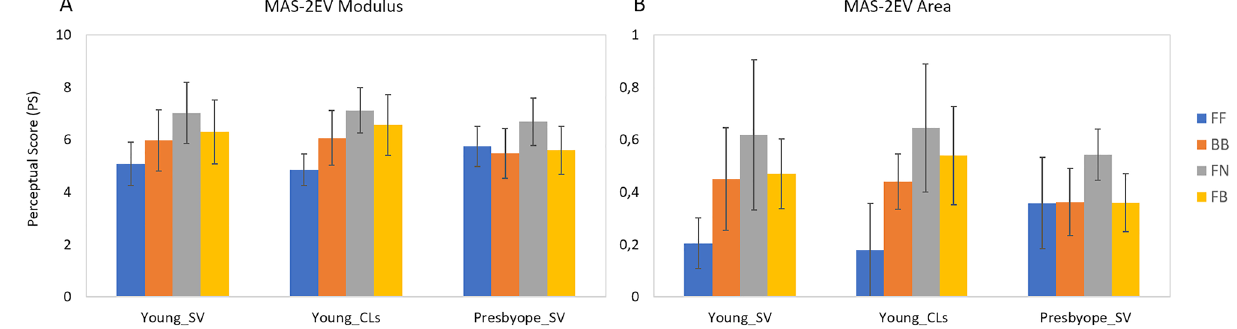
Figure 5. ( A ) MAS-2EV Modulus (average of the five polygon vertices: NS and the four PS averaged across subjects for each group), for all corrections. ( B ) MAS-2EV Area (normalized areas averaged across subjects for each group), for all corrections.